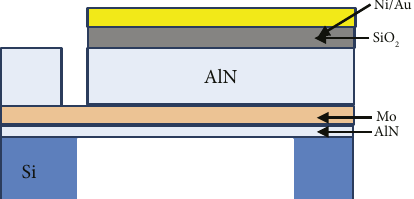
Figure 2: Te design of AlN-based flm bulk acoustic resonator. Te piezoelectric material of the sensor is